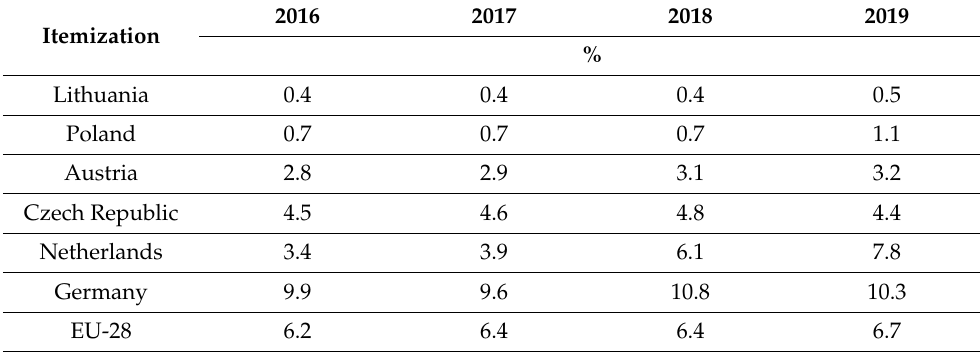
Table 2. Structure of solar energy acquisition in EU countries from 2016 to 2019.